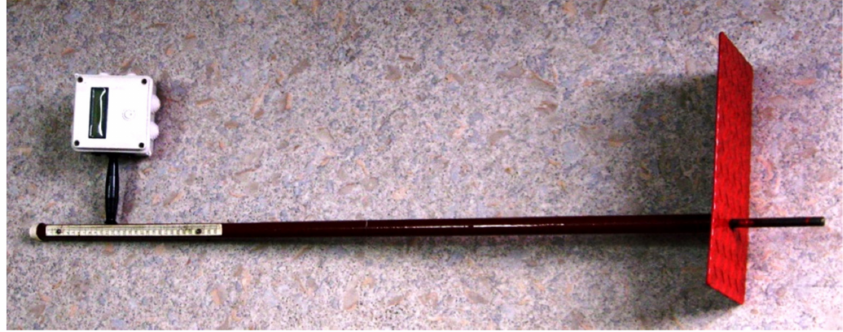
Figure 5. Kit for measuring tillage depth.